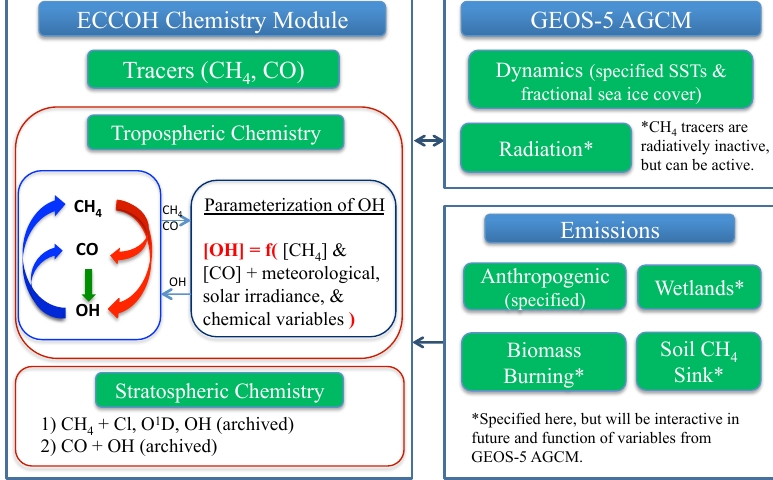
Figure 1. Schematic representation of the implementation of the ECCOH module within the GEOS-5